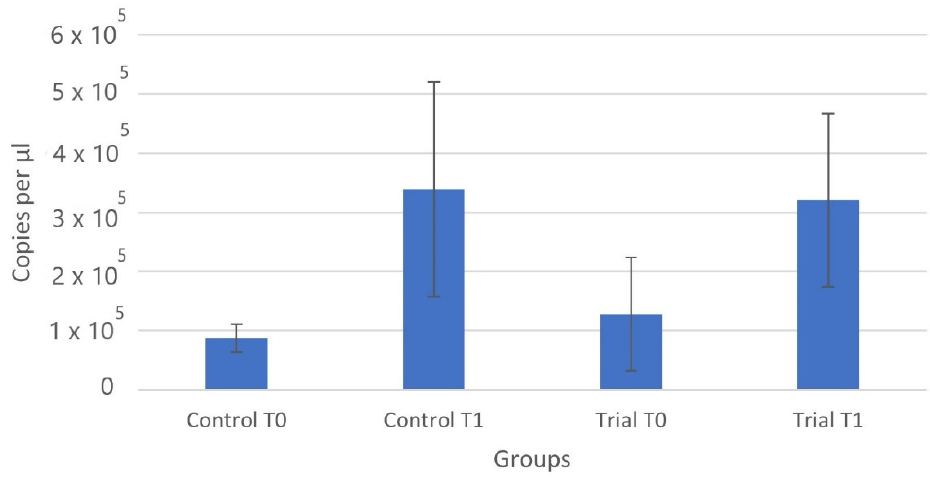
Figure 4. Total bacterial count expressed as copies/microlitre (this figure shows the data reported in Table